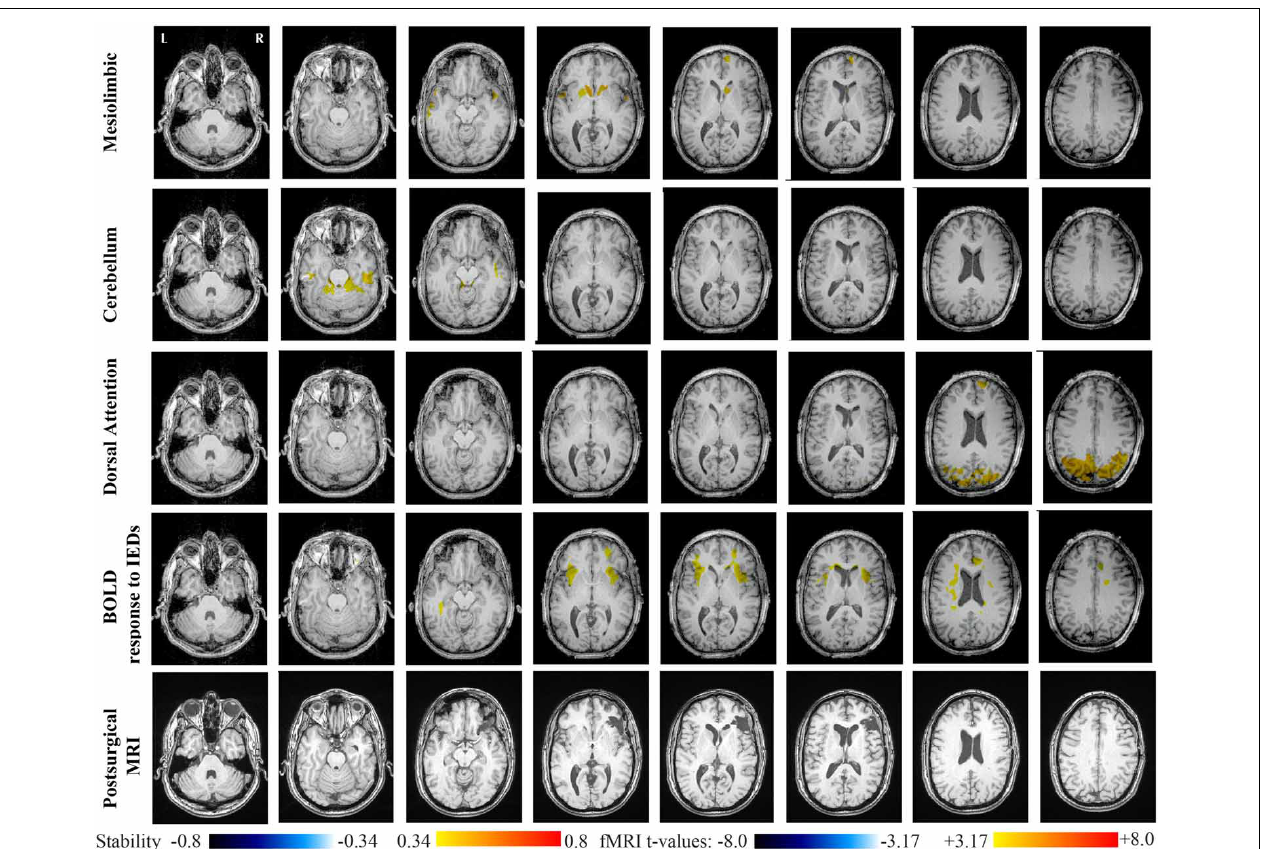
FIGURE 7 | Evaluation of DANI on Patient 2 with right Orbito-Frontal epilepsy. Results are presenting most salient stability changes observed in Cmap n followed by a t-map of the BOLD response to epileptic discharges and a postsurgical T1 MRI, all resampled in the native anatomical MRI space of the patient.